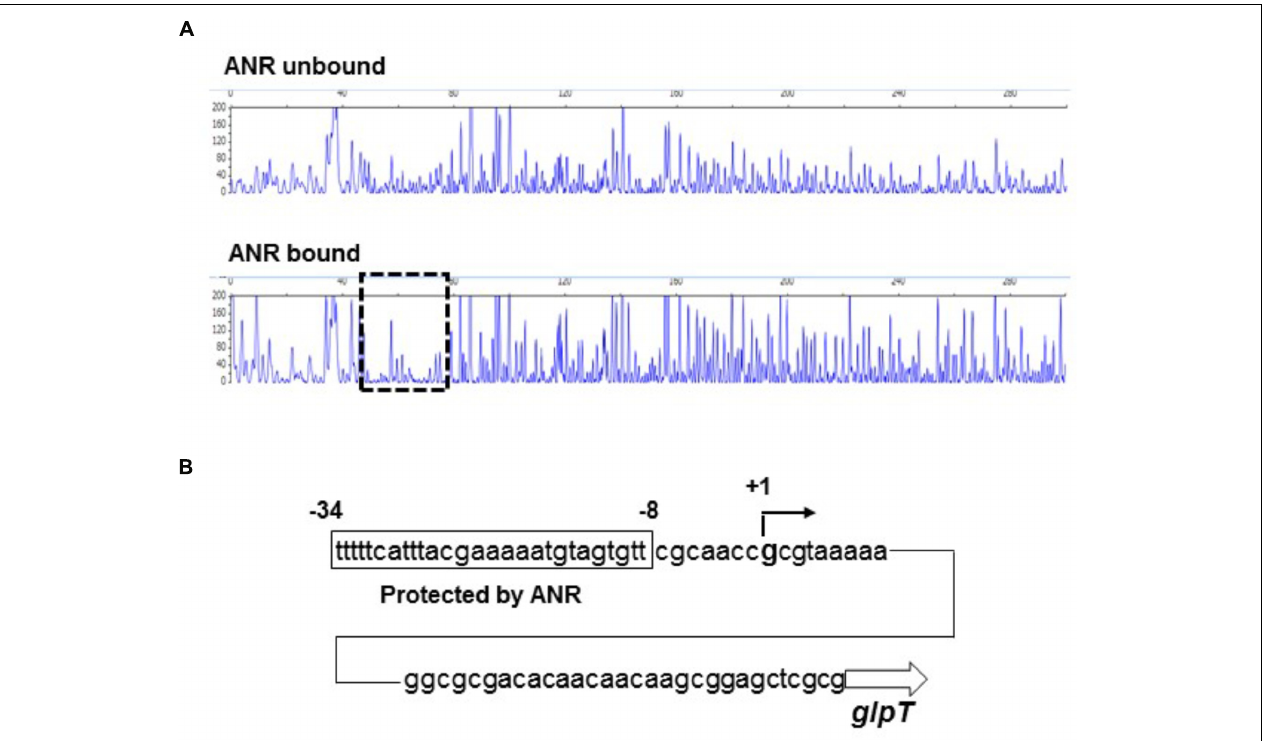
FIGURE 3 | Sequence of the upstream glpT region and identification of ANR binding site and glpT transcriptional start site. (A) DNase I footprinting of the glpT promoter region. A 6-FAM-labeled DNA fragment was incubated in the presence or absence of ANR (30 pmol) and subjected to DNase I digestion. The fluorescence intensities of the DNA fragments ( y- axis) are plotted relative to their size in bases ( x- axis). One region (outlined by the dashed line) was protected from DNase I digestion in the presence of 30 pmol ANR protein. (B) Mapping of ANR binding site and glpT transcriptional start site on the glpT upstream region. The region protected from DNase I digestion is indicated by the box. Numbers indicate relative positions to the transcriptional start site.